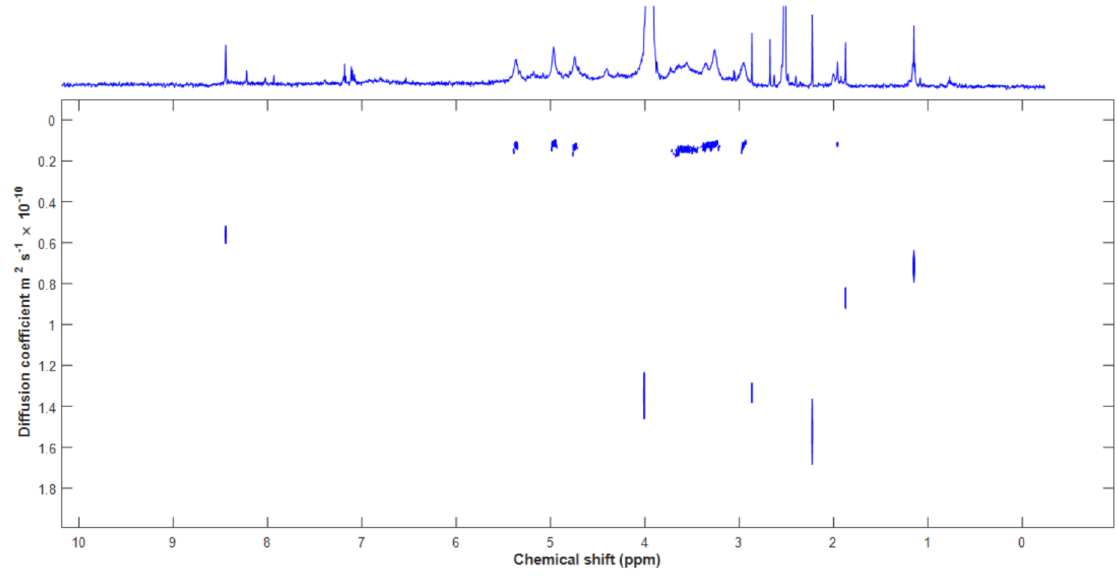
Figure 7. Crowded 1 H-detected DOSY of chemically modified wood dissolved in DMSO -d 6 /LiCl corresponding to the 19 F-DOSY counterpart depicted in Figure